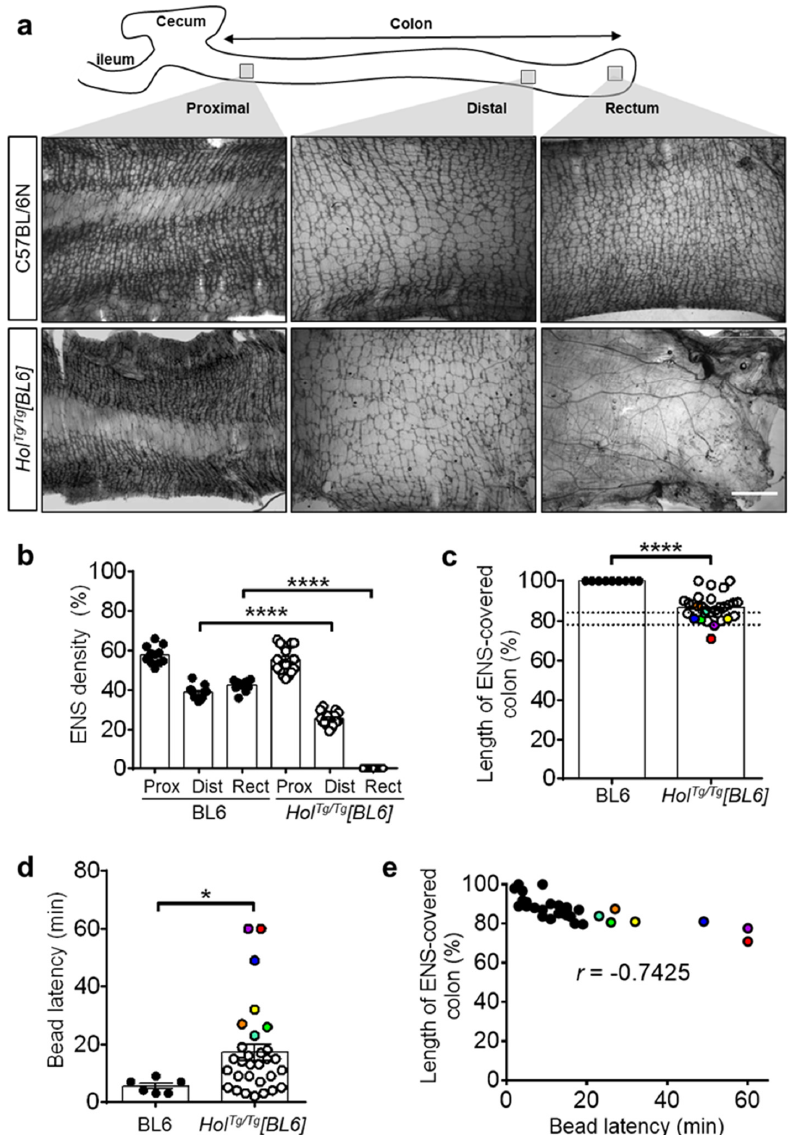
Figure 2. Hol Tg/Tg [BL6] mice display short-segment aganglionosis and colonic dysmotility. ( a ) Stain- ing of AChE activity in muscle strips from P20 mice, evidencing hypoganglionosis in the distal colon and aganglionosis combined to an overabundance of extrinsic nerve fibers in the rectum of Hol Tg/Tg [BL6] . Scale bar, 1 mm. ( b ) Quantitative analysis of the area occupied by the myenteric plexus (expressed in % of the image area), using images such as those displayed in ( a ). Each value is a field a view, for a minimum of 3 fields of view per region ( n = 3–5 animals per group). Values for the aganglionic rectum of Hol Tg/Tg [BL6] mice were set at 0% by default, to avoid the confounder extrinsic nerves. **** p < 0.0001, one-way ANOVA with post-hoc Sidak’s test. ( c ) Quantitative analysis of the length of ENS-covered colon (in % of total colon length) in P20 mice. The dashed lines refer to the previously described threshold level interval beyond which megacolon is less likely to occur in FVB/N mice [35,36]. **** p < 0.0001, two-tailed Student’s t -test. ( d ) In vivo analysis of colonic motility in P20 mice using the bead latency test. Time to expel the glass bead after rectal insertion was capped at 60 min to simplify the analysis without impacting statistical significance. * p < 0.05, two-tailed Mann–Whitney U test. ( e ) Correlation between length of ENS-covered colon and time to expel the bead. Colored symbols were attributed to all Hol Tg/Tg [BL6] mice with latency time above average in panel d and used to highlight the same mice in panels c and e. r , Pearson’s correlation coefficient.